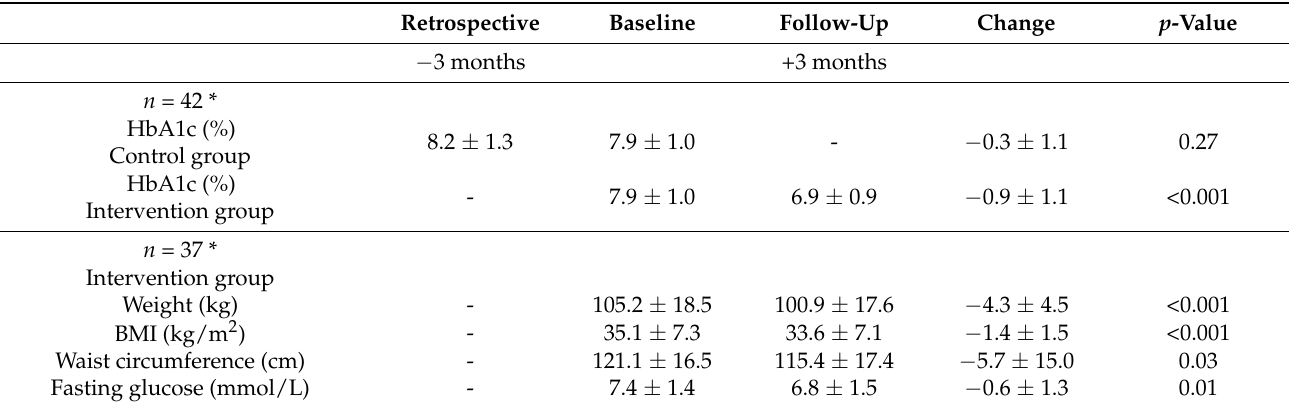
Figure 2. Study flow diagram. HbA1c = glycated hemoglobin, PRO = patient reported outcomes. Table 1. Effects on glycemic control and metabolic